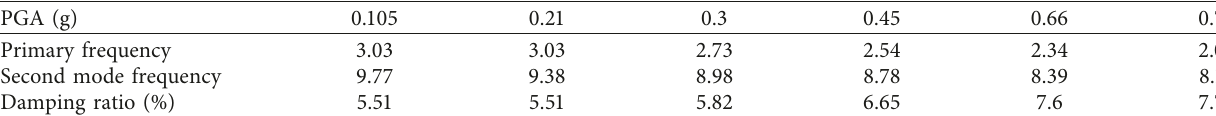
Table 12: Damping and frequency of optimization model.